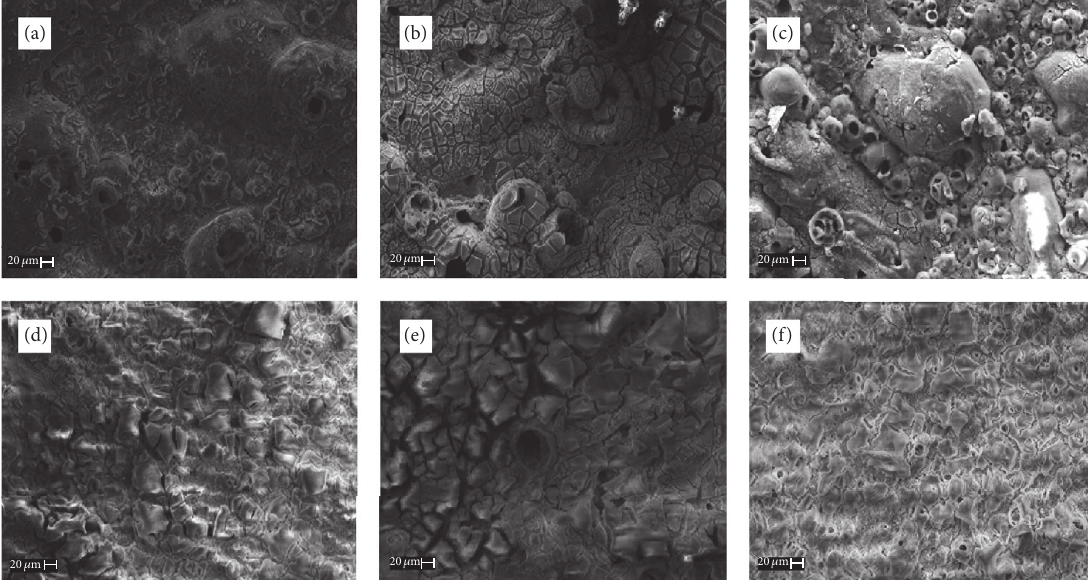
Figure 7: Scanning electron micrographs (secondary electrons) of the surface and cross section of sealing coatings formed on AZ91 magnesium alloy with 12 g/l of La(NO 3 ) 3 with different treatment times and temperature: (a) 30 ∘ C, 10min; (b) 30 ∘ C, 30 min; (c) 40 ∘ C, 10min; (d) 40 ∘ C, 30 min; (e) 50 ∘ C, 10min; (f) 50 ∘ C, 30